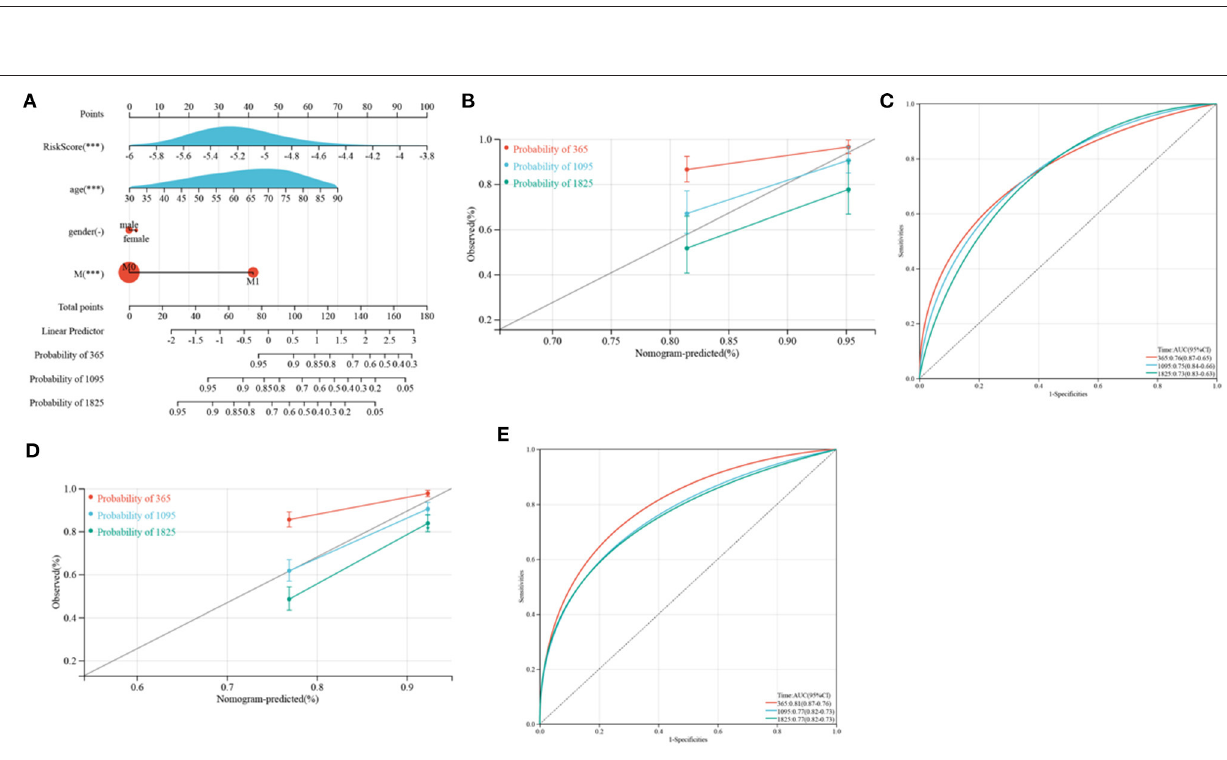
FIGURE 12 | Development and verification of a nomogram. (A) Nomogram for anticipating the 1, 3, and 5-year OS of CRC patients in TCGA cohorts. (B,D) Calibration plots of the nomogram to anticipate 1, 3, and 5-year OS in the TCGA (B) and GEO (D) cohorts. (C,E) ROC plots predicting the 1, 3, and 5-year survival in the TCGA (C) and GEO (E)